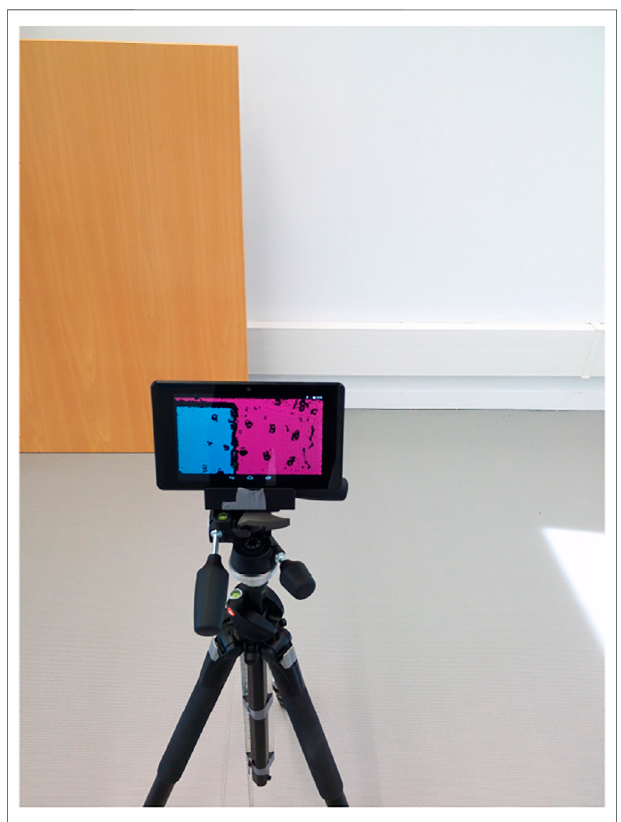
FIGURE 9 | Setup used for evaluation precision.